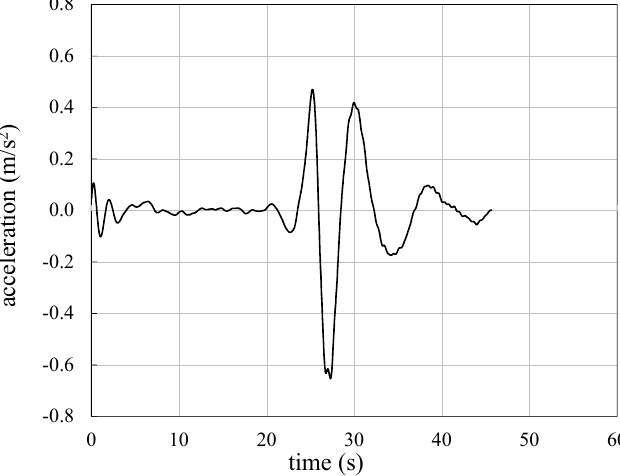
Figure 5. Equivalent base acceleration time history for the extreme operating gust (EOG) wind load case.